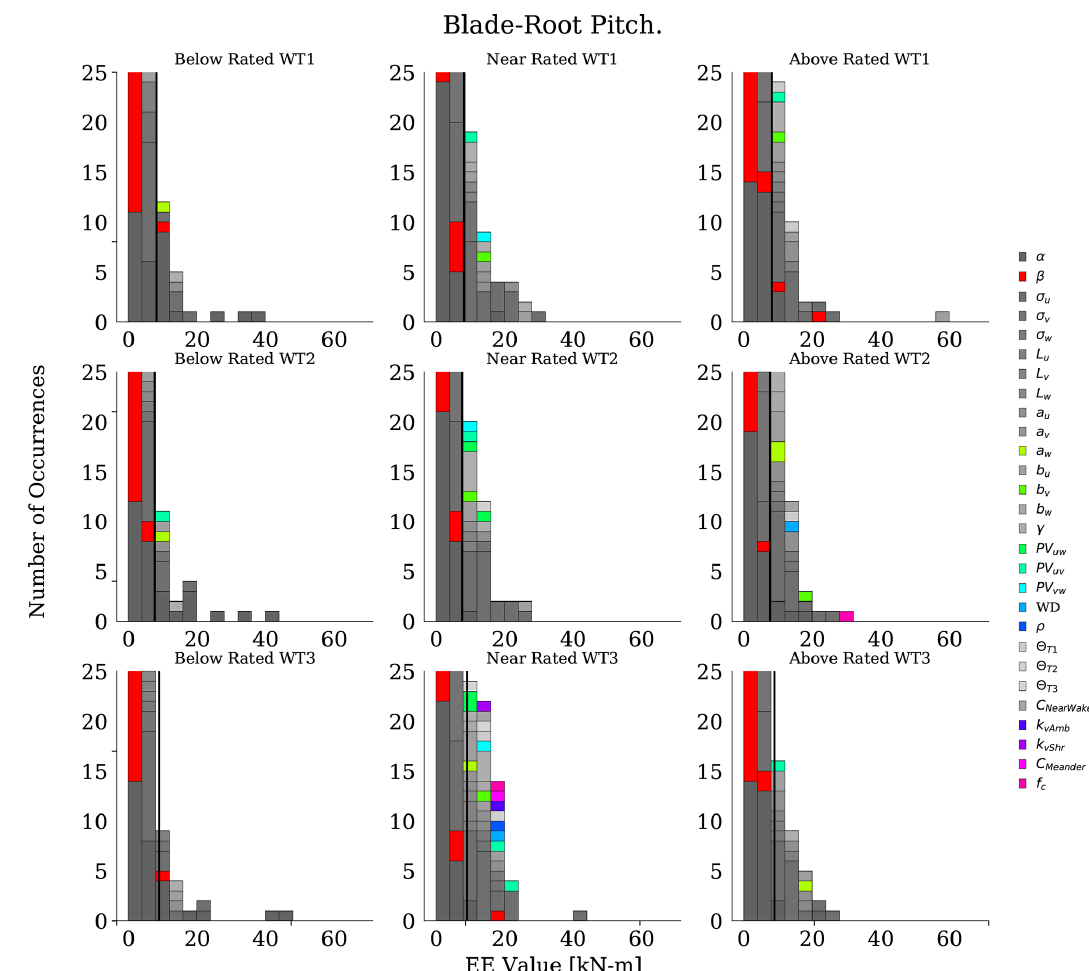
Figure 7. Histograms of fatigue load EE values for the blade-root pitching moment. Each graph shows one wind speed bin and wind turbine and includes all input parameters. Each column of subplots corresponds to a wind speed bin and each row of subplots corresponds to a wind turbine. The vertical lines on each plot correspond to the threshold value used to identify significant events. The y axis has been limited to focus on results contributing to significant event count.